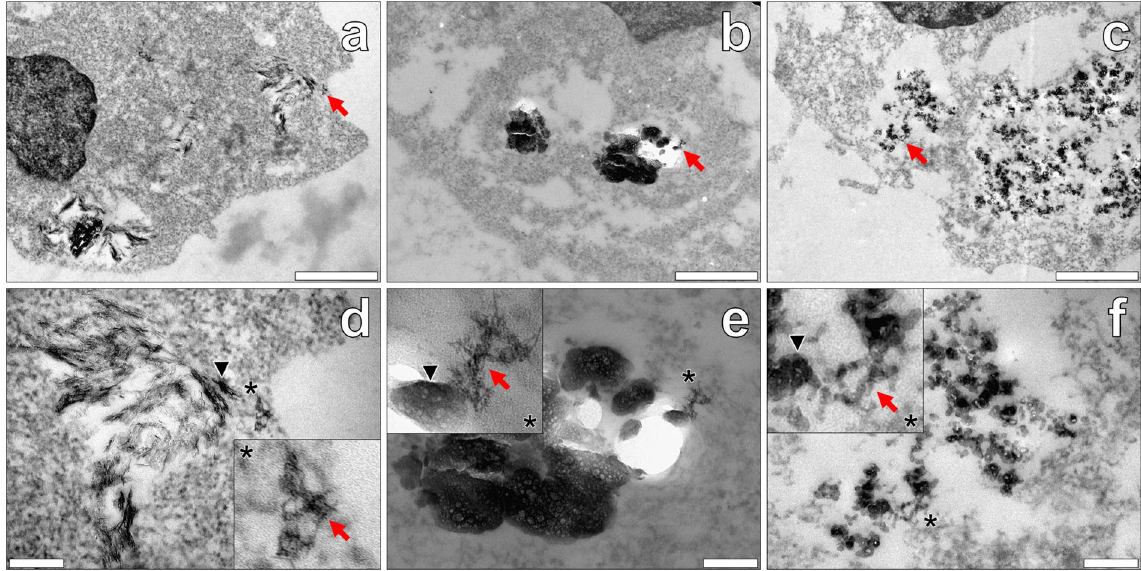
Figure 4. Representative electron micrographs from TEM of Spurr resin-sectioned (100 nm sections) THP-1 cells co-cultured with simulated vaccine formulations. Cells were co-cultured for 24 h in R10 medium with 4 μ M A β 42 in the presence of 50 μ g/mL Alhydrogel ® (Brenntag Biosector, Denmark) ( a and d ), Imject ™ Alum (Pierce, Thermo Scientific) ( b and e ) or Adju-Phos ® (Brenntag, Denmark) ( c and f ). ThT and lumogallion at 10 and 50 μ M respectively, were added at 21 h, as with fluorescence analyses of THP-1 ABA co-cultures. Cell resin-sections were stained for 20 min with 2% w/v ethanolic uranyl acetate, rinsed with 30% v/v ethanol followed by ultrapure water. Grids containing sections were allowed 24 h drying time prior to analysis via TEM. Inserts show close-ups of intracellular negatively stained amyloid (red arrows) co-deposited with ABA (black arrows) within the respective cell images. Magnification & scale bars: ( a–c ) X 30 K, 1 μ m, ( d–f ) X 100 K, 0.2 μ m,